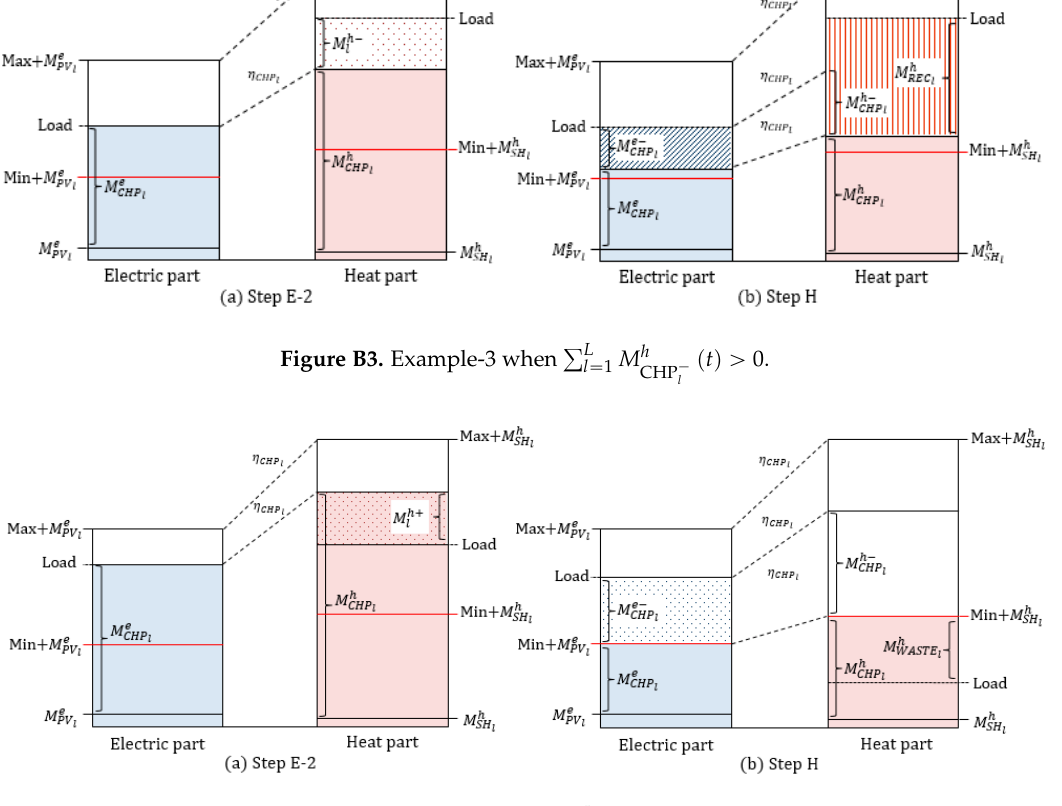
Figure B4. Example ‐ 4 when ∑ Figure B4. Example-4 when